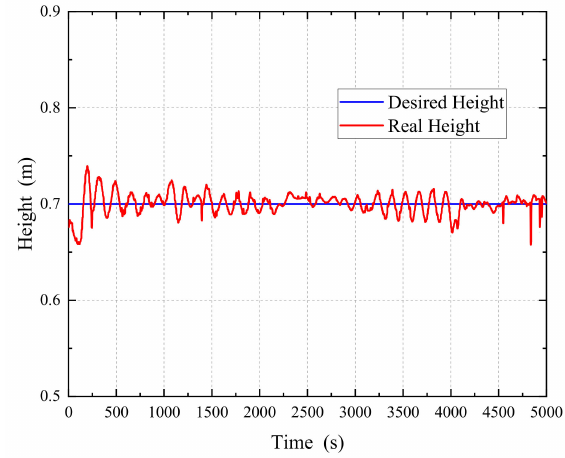
Figure 14. Height during voyage.